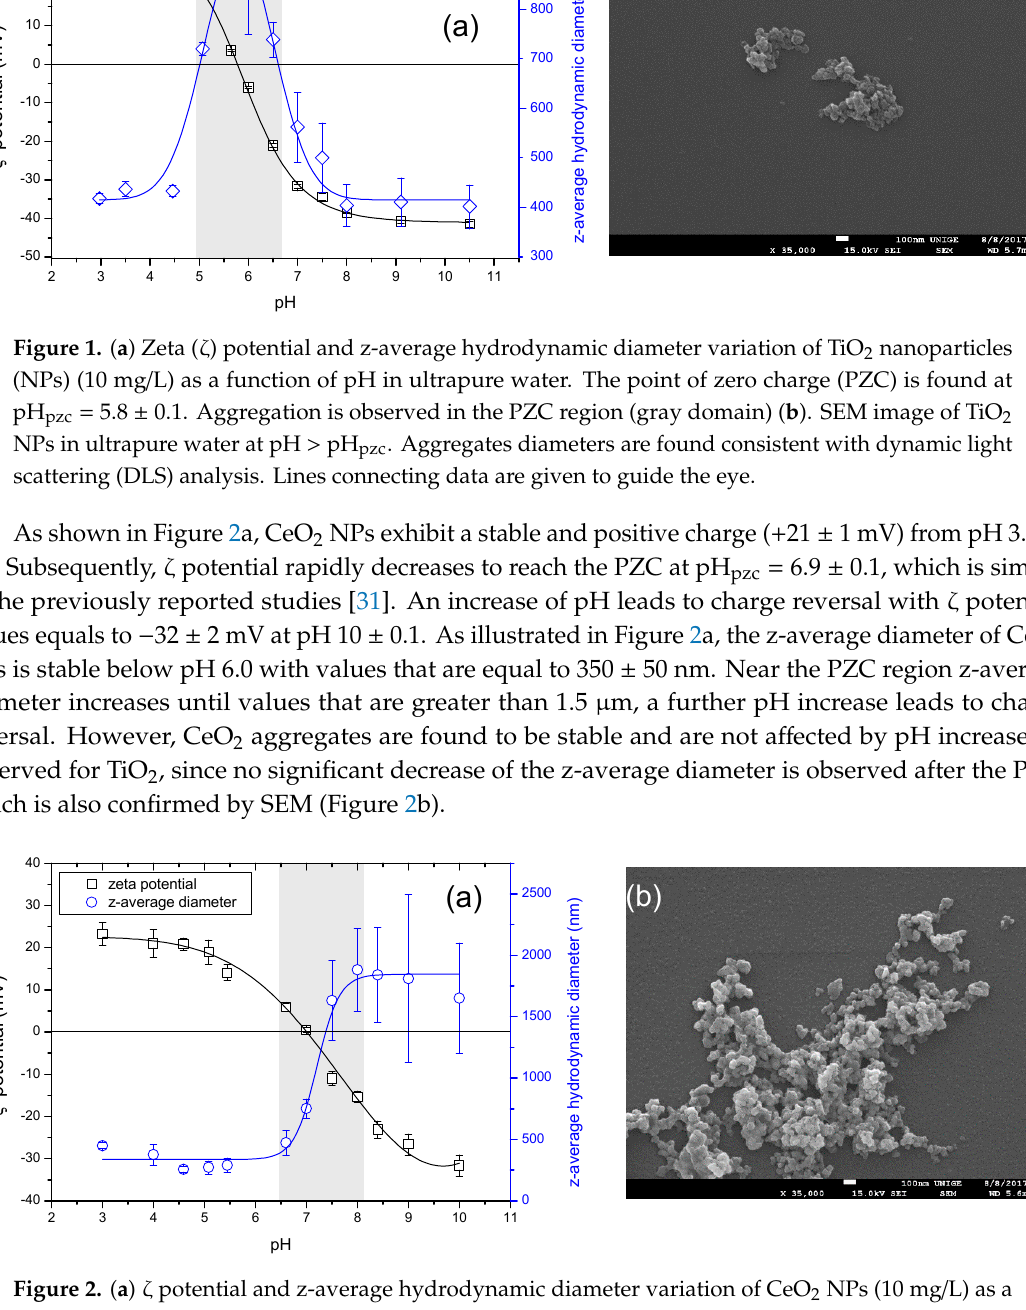
Figure 2. ( a ) ζ potential and z-average hydrodynamic diameter variation of CeO 2 NPs (10 mg/L) as a function of pH in ultrapure water. The point of zero charge (PZC) is found equal to pH pzc = 6.9 ± 0.1. Strong aggregation is observed around the PZC region (gray domain) in agreement with SEM image ( b ) SEM image of CeO 2 NPs aggregates in ultrapure water at pH > pH pzc.